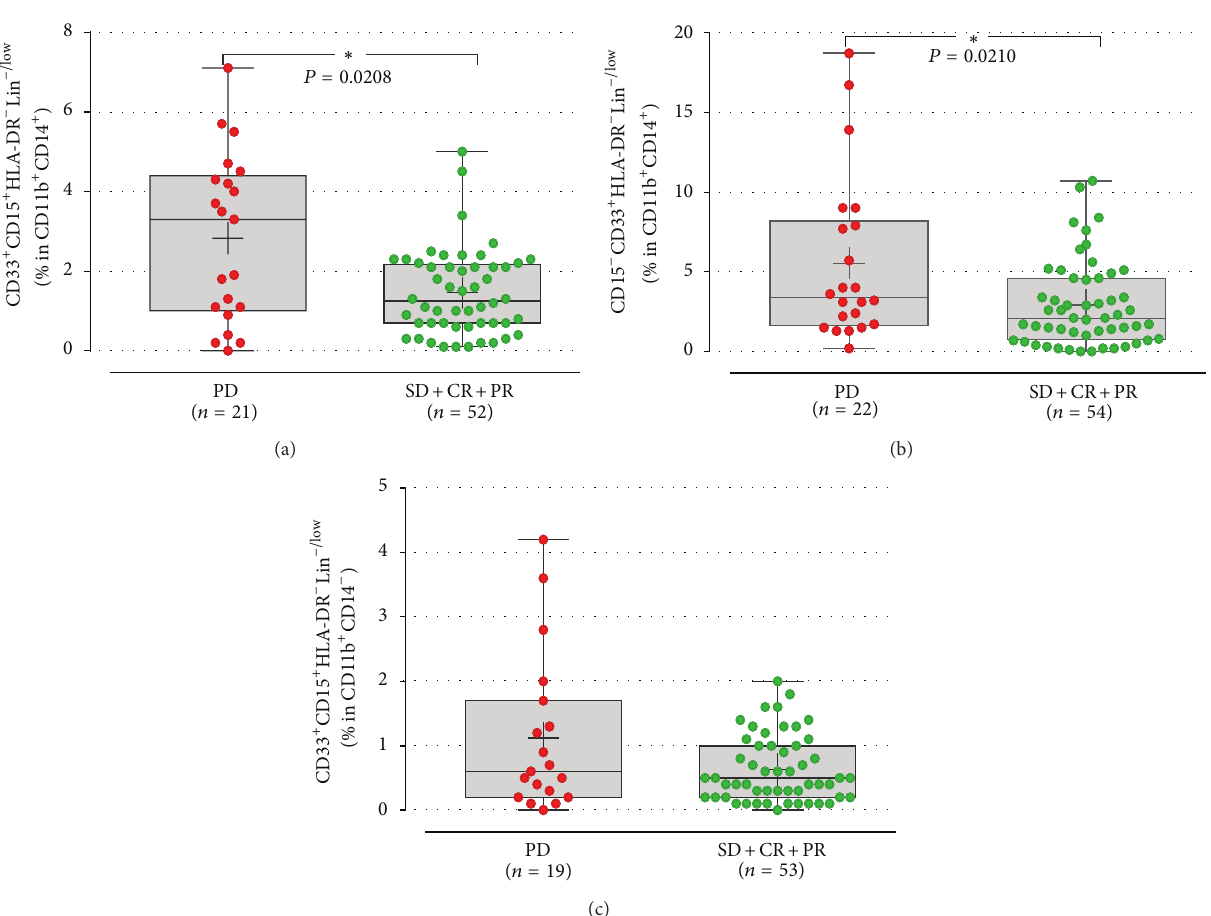
Figure 4: Response to 1st line treatment in patients according to the MDSC expression at baseline. The percentages of both monocytic (a) and (b), but not the granulocytic (c), subpopulations of MDSCs were increased in patients with disease progression (PD) compared to those with disease control after therapy. Each point corresponds to an individual patient or healthy controls. The medians, 75 percentile (box), and max and min (whiskers) are represented. Groups were compared by Mann-Whitney